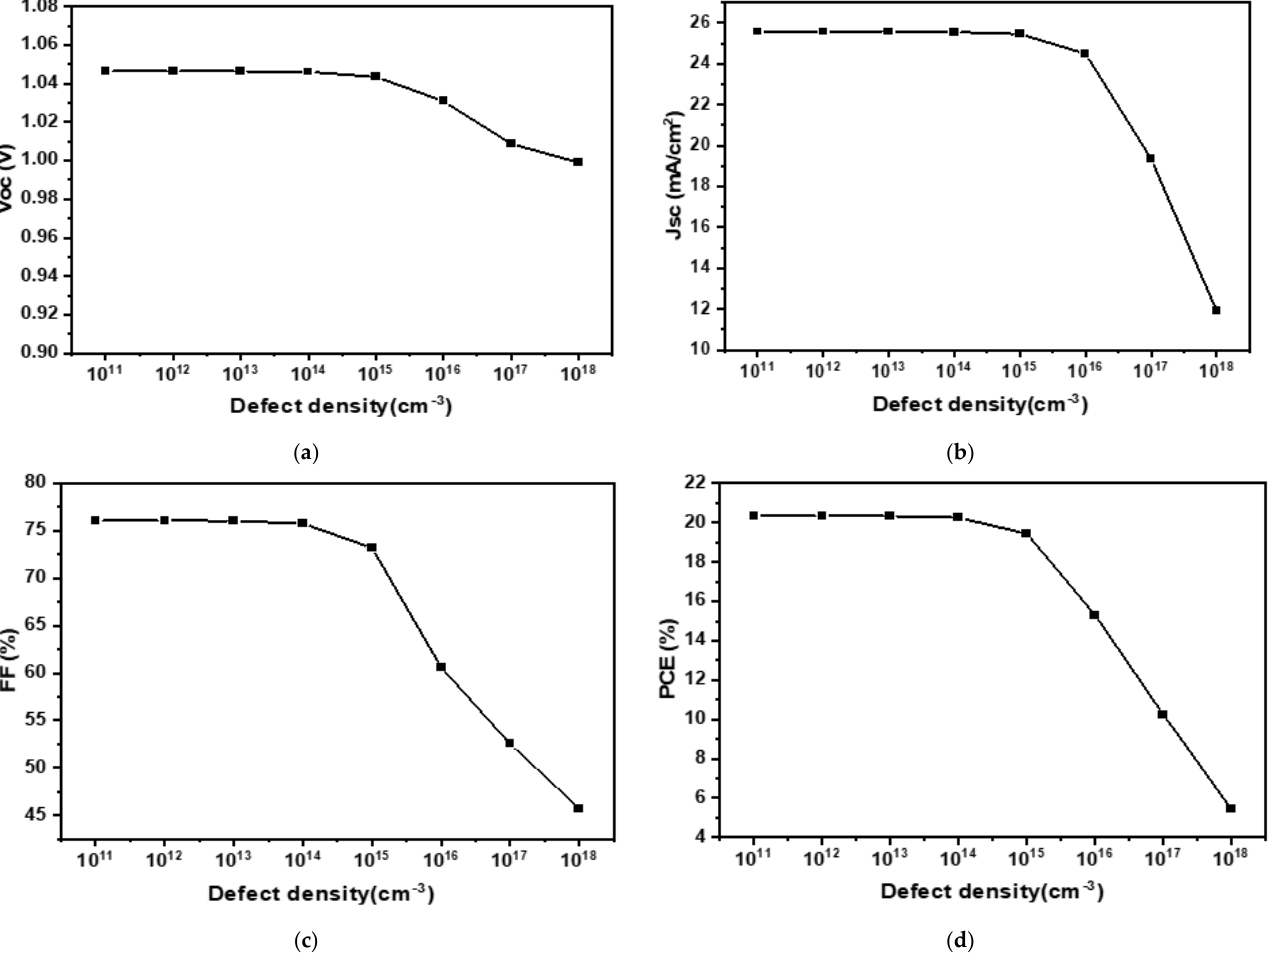
Figure 8. Effect of PAL defect density on ( a ) Voc, ( b ) Jsc, ( c ) FF, and ( d ) PCE.